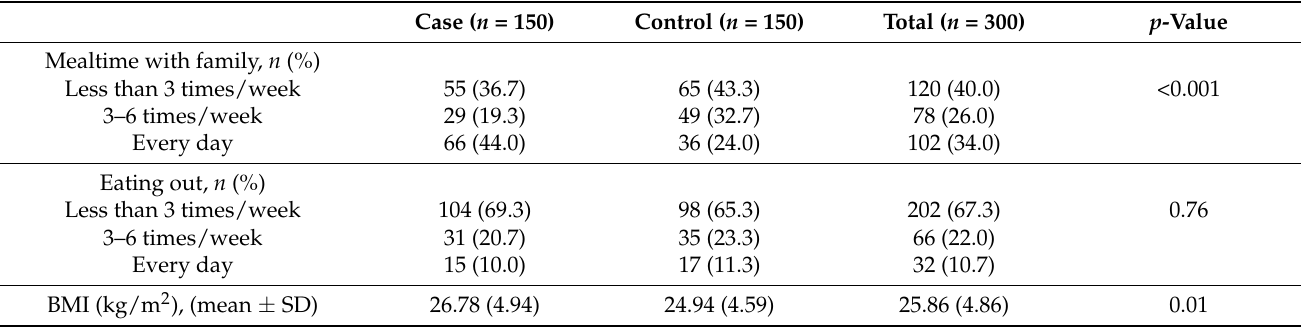
Table 2. Health assessments of the